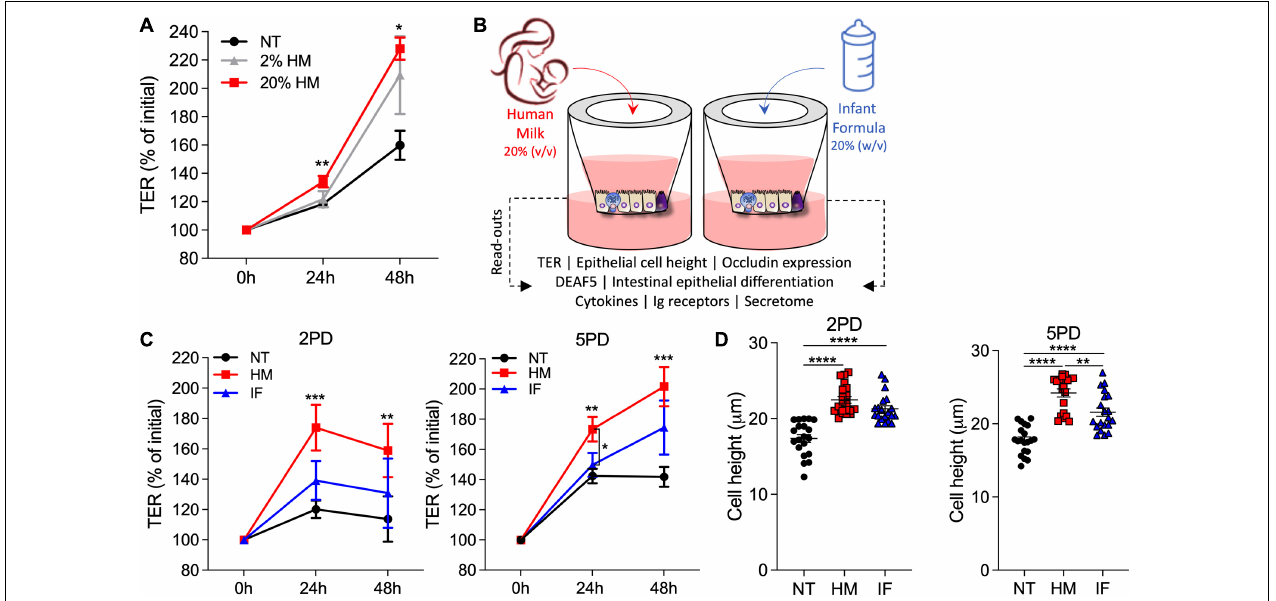
FIGURE 2 | Human milk decreases ion permeability of the pediatric intestinal epithelium. (A) TER values of 2PD monolayers apically exposed to human milk (HM) 2 or 20% (v/v). (B) Schematic representation of pediatric HIE treatment and biological readouts. (C) TER measurement of 2PD and 5PD monolayers apically treated with 20% (v/v) of HM or 20% (w/v) of commercial infant formula (IF). (A,C) Mean ± SEM are shown. Data are representative of three independent experiments with n = 3–6 enteroid monolayers/group per experiment. p -values were calculated by Mann Whitney test. Unless indicated, p -values correspond to treated vs. non-treated (NT) controls. (D) Epithelial cell height quantified by immunofluorescent microscopy ( ≥ 10 different view fields). Data represent mean ± SEM of three combined experiments, each including four monolayers/group per experiment. Each symbol indicates an independent monolayer. p -values were calculated by one-way ANOVA with Tukey post hoc analysis. * P < 0.05; ** P < 0.01; *** P < 0.001; **** P <